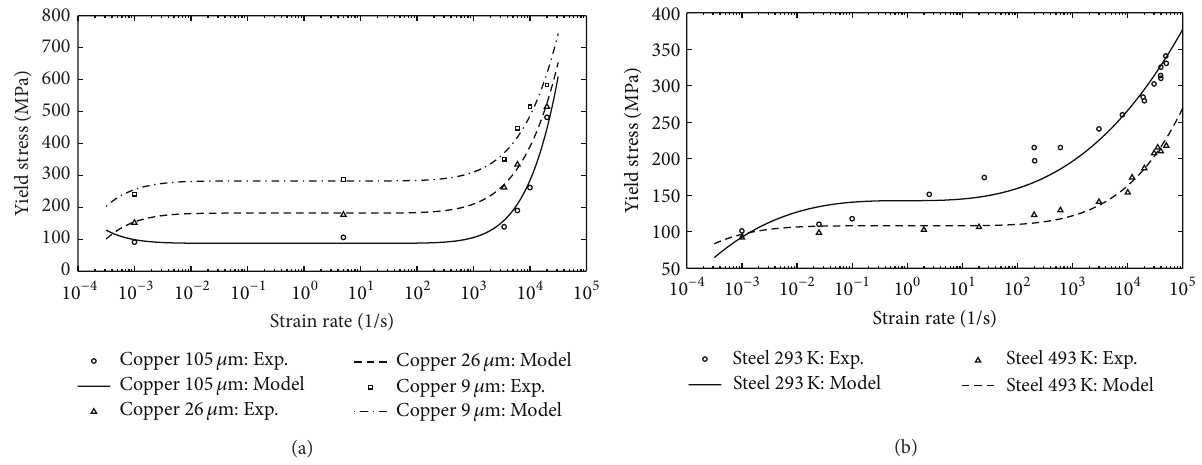
Figure 3: Yield stress fitting by the Tuazon et al. model: (a) copper and (b) steel.